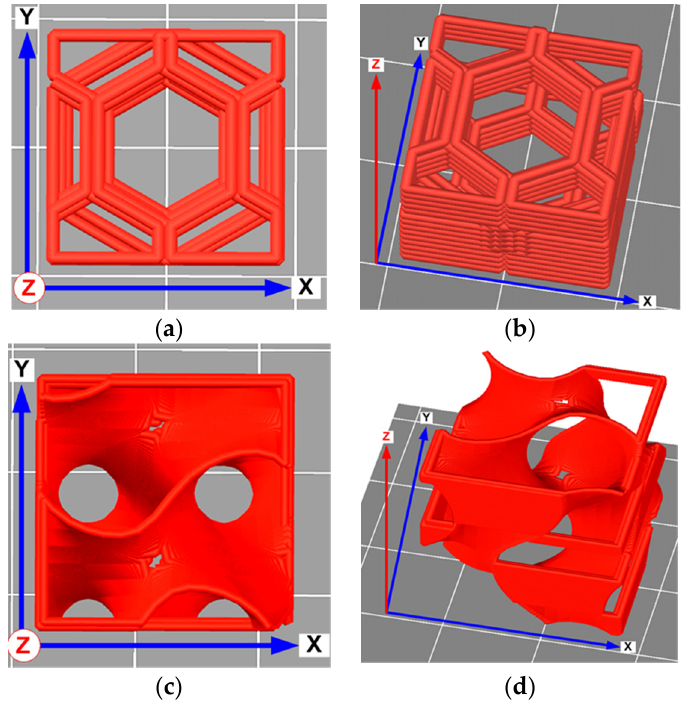
Figure 2. Isometric views of individual cells of honeycomb ( a , b ) and gyroid ( c , d )